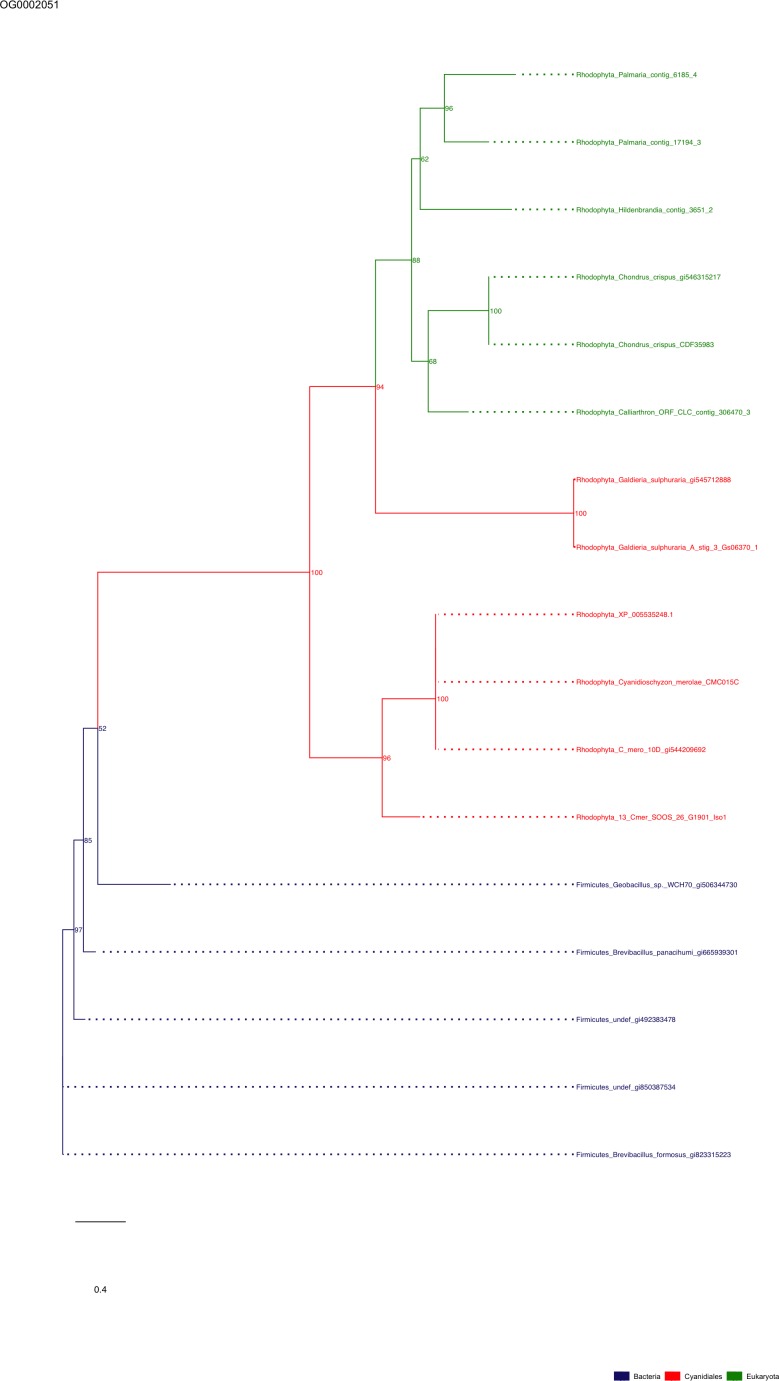
Sequence tree of orthogroup OG0002051.The tree is based on amino acid sequences. Archaea (yellow), Bacteria (blue), Cyanidiales (red), Eukaryotes including other red algae (green). Branches containing Cyanidiales sequences are highlited in red.